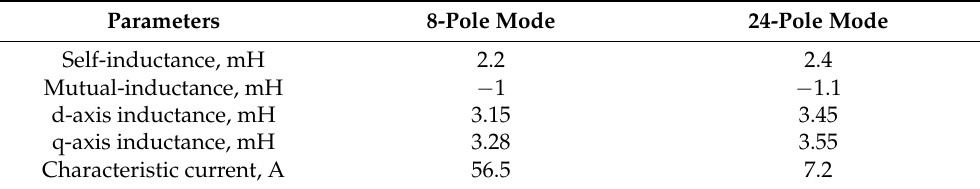
Table 3. Inductances by FEA.